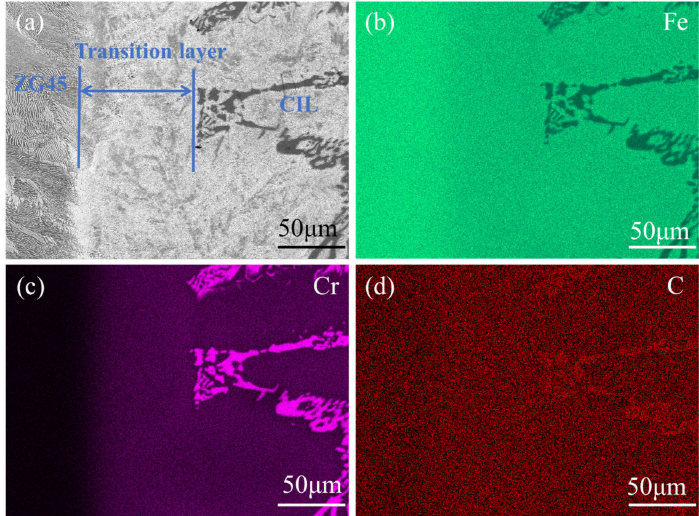
Figure 7. The interface of CIL-4. ( a ) SEM image; EDS mapping scanning analysis of ( b ) Fe, ( c ) Cr and ( d )